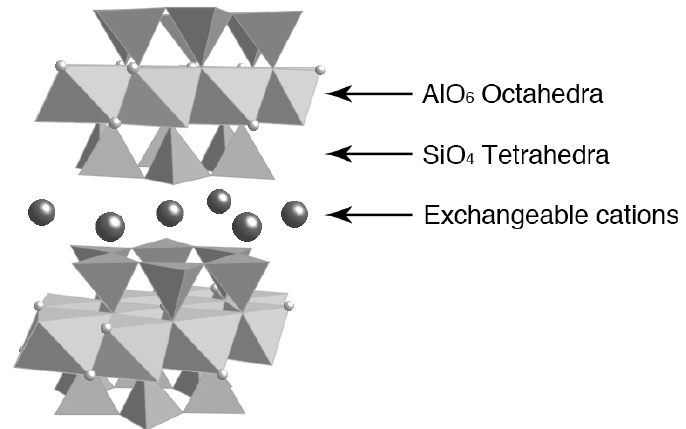
Figure 3. Crystal structure of smectite-type clay,